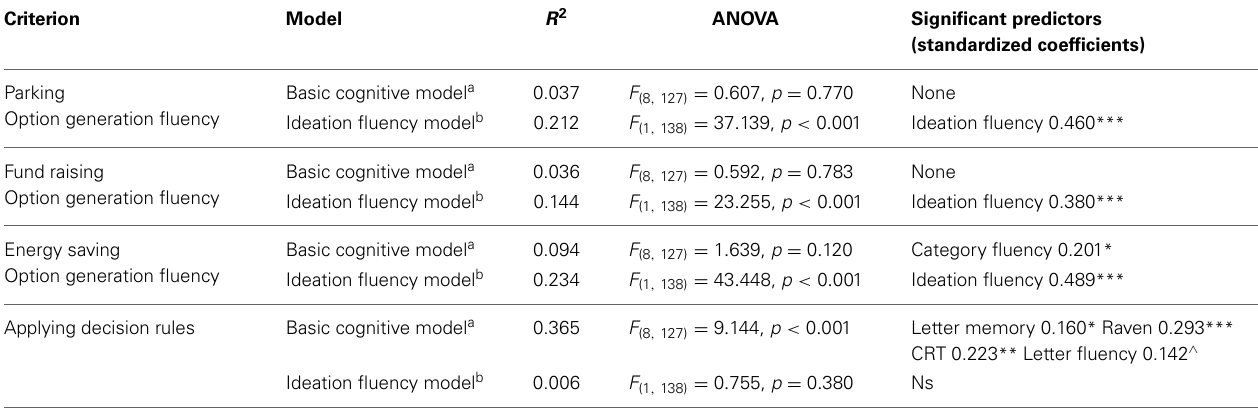
Table 2 | Multiple regression results.